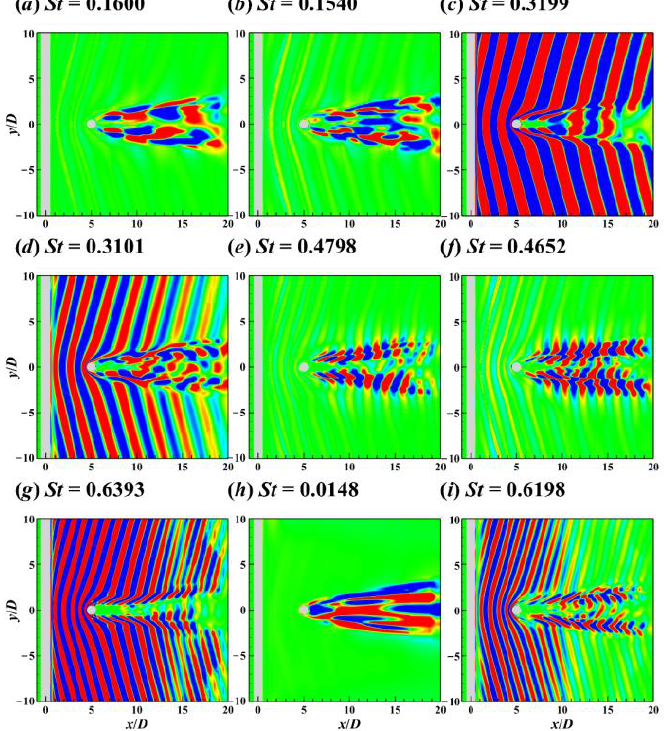
Figure 32. Contours of the St = 0.1600 ( a ), 0.1540 ( b ), 0.3199 ( c ), 0.3101 ( d ), 0.4798 ( e ), 0.4652 ( f ), 0.6393 ( g ), 0.0148 ( h ), and 0.6198 ( i ) DMD modes on the xy plane for the flow around the two crossing cylinders in 90° arrangement.